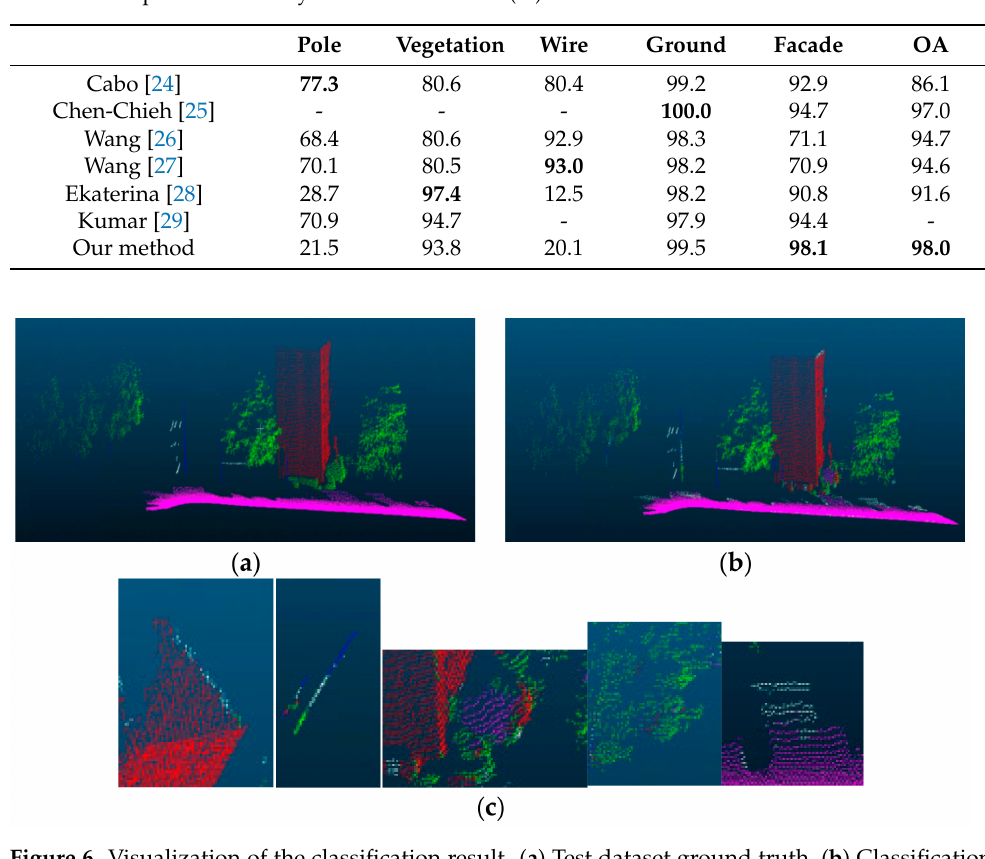
Figure 6. Visualization of the classification result. ( a ) Test dataset ground truth, ( b ) Classification result of our method, ( c ) Details of our classification